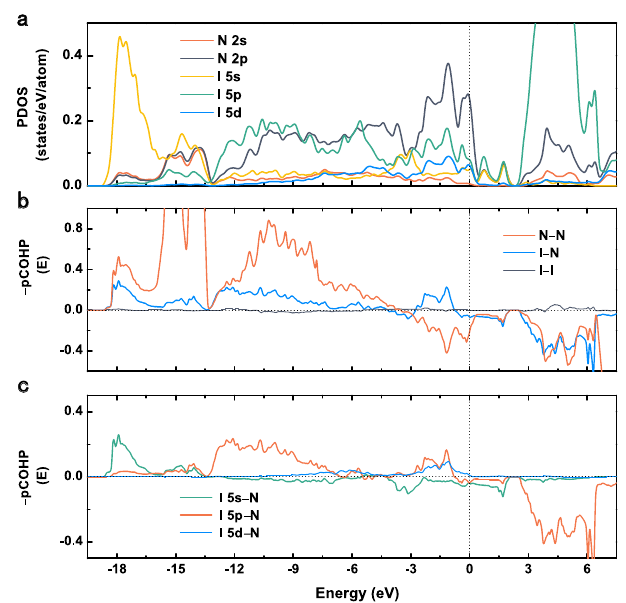
R-- Fig. 3 Electronic structure of 3 m -IN 6 at 100 GPa. a Projected density of states (PDOS). The Fermi energy is set to zero. b Crystal orbital Hamilton population (COHP) of N – N, I – N, and I – I pairs. c The projected COHP (pCOHP) of I – N pairs. Positive and negative – pCOHP values denote bonding and antibonding interactions, respectively. Source data are provided as a Source Data fi